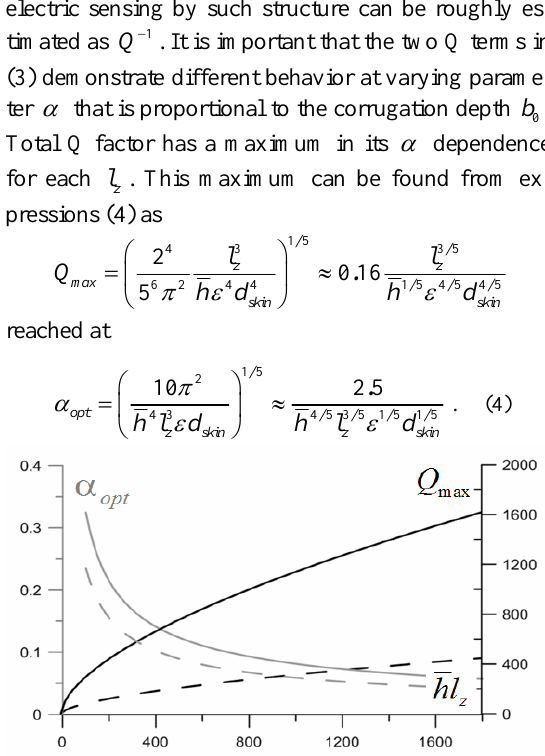
Fig. 3. Optimal  (gray) and maximum Q (black) and vs. length of the resonator. Solid lines correspond to copper structure in vacuum, dashed lines correspond 5 